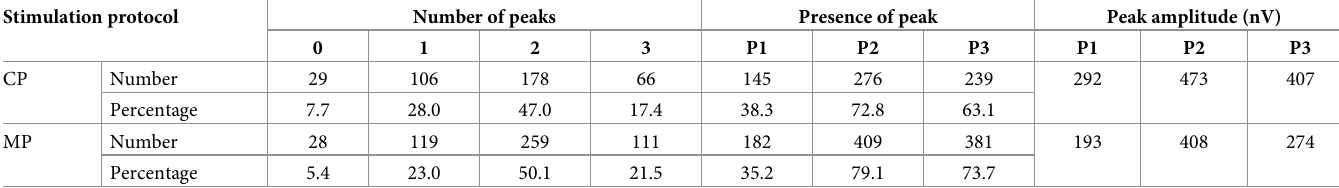
Table 2. Peaks characterization of the EABR waveforms recorded with the two different stimulation protocols. Stimulation protocol